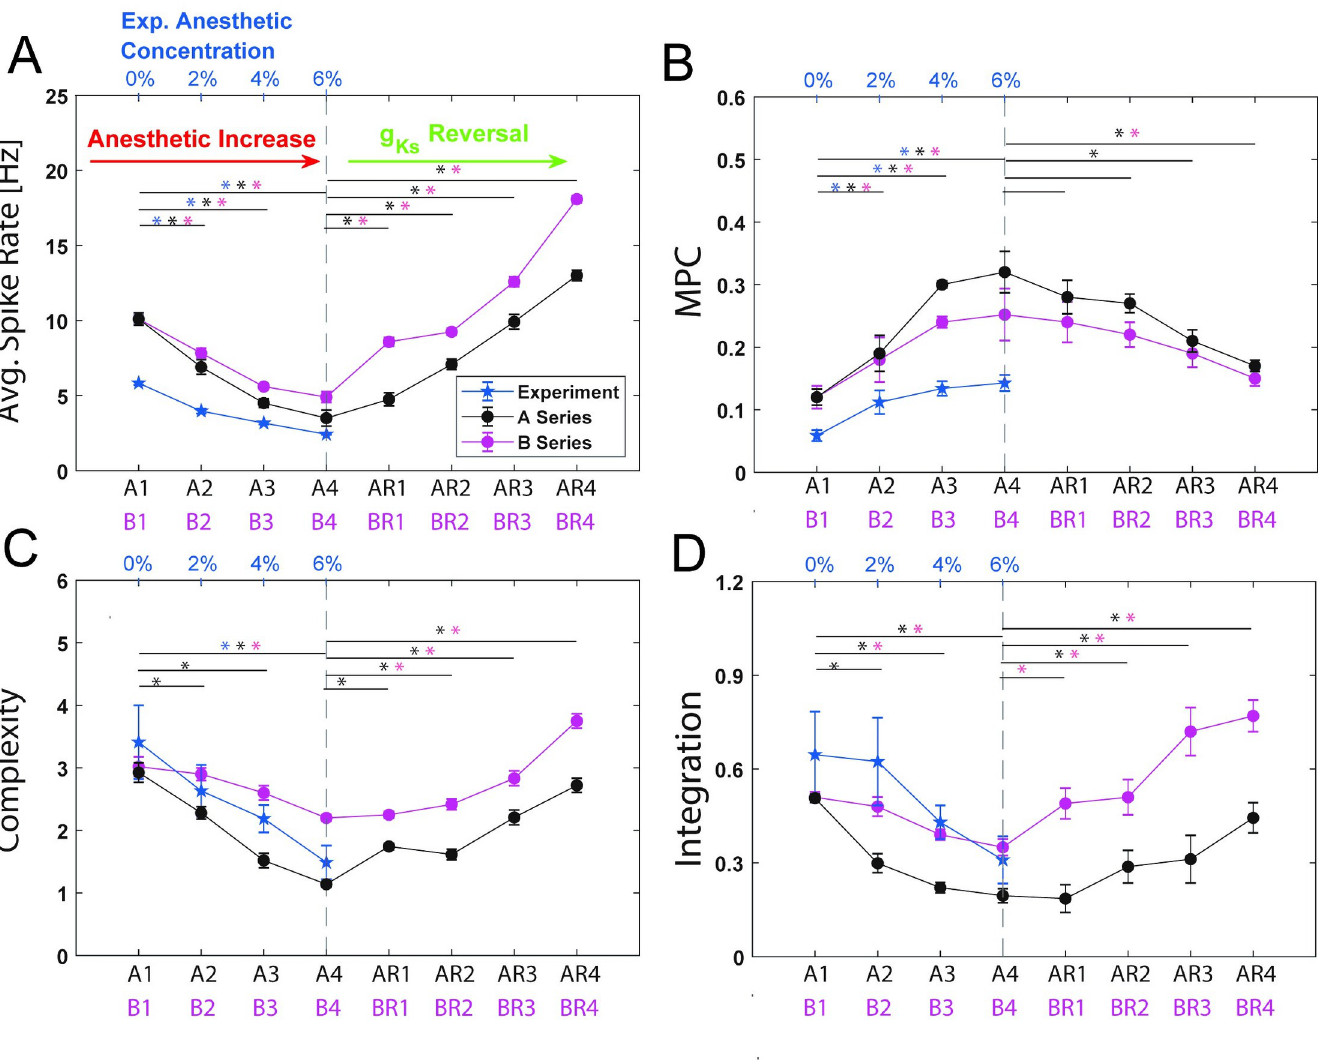
Fig 4. Characterization of anesthetic effects on network dynamics and their simulated ACh reversal for best fit. Measures of network dynamics computed from experimental data and optimized model networks as a function of anesthetic concentration and simulated reversal level: A) Average spike rate B) . Mean Phase coherence C) Complexity C(X) D) Integration I(X). A1-AR4/B1-BR4 (x-axis) denote simulated anesthetic concentration levels and reversal states obtained in optimized networks with corresponding parameters listed in Table 2 . Black line denotes simulations with A-series parameter sets (g Ks constant) and pink line denotes simulations with B-series parameter sets (changing g Ks ). Blue line (with corresponding axis labels on the top) denotes measures computed from experimental spiking data at different desflurane concentrations. Stars denote significance between initial anesthetic/reversal and subsequent simulations. All calculations were made for 6s intervals and then averaged over 5 intervals. Error bars are +/-SEM based on 10 network realizations. Results from lowest cost fit parameters.